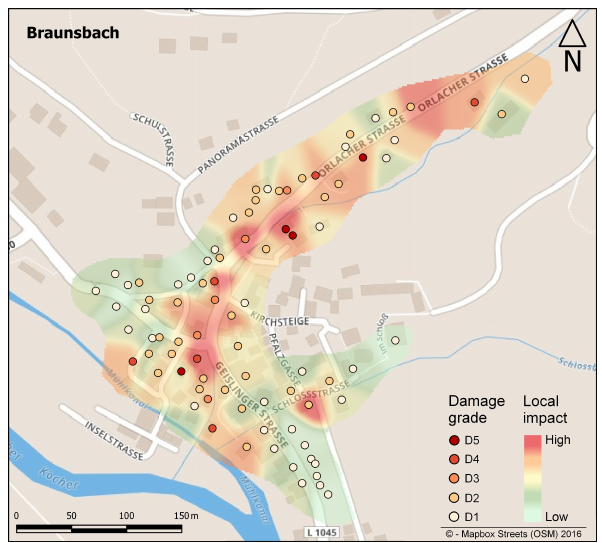
Figure 6. Map of the study area with the local impact, which is a combination of the inundation depth at the building and its ex- position in flow direction (see text for further details). Further, the damage grades as recorded on site using the classification scheme of Schwarz and Maiwald (2007) are shown; see Table 1 for a verbal description of the damage